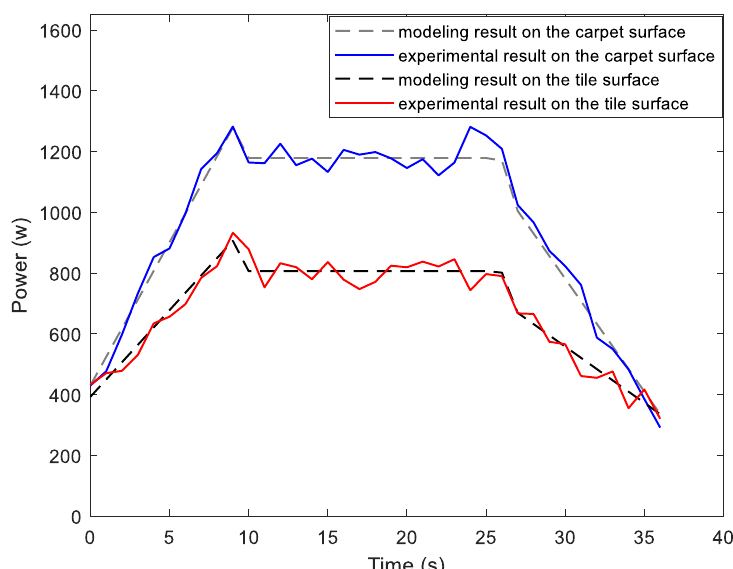
Figure 7. Energy model verification experiment.